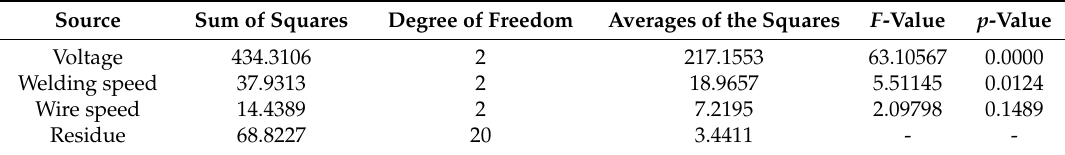
Table 5. ANOVA for the